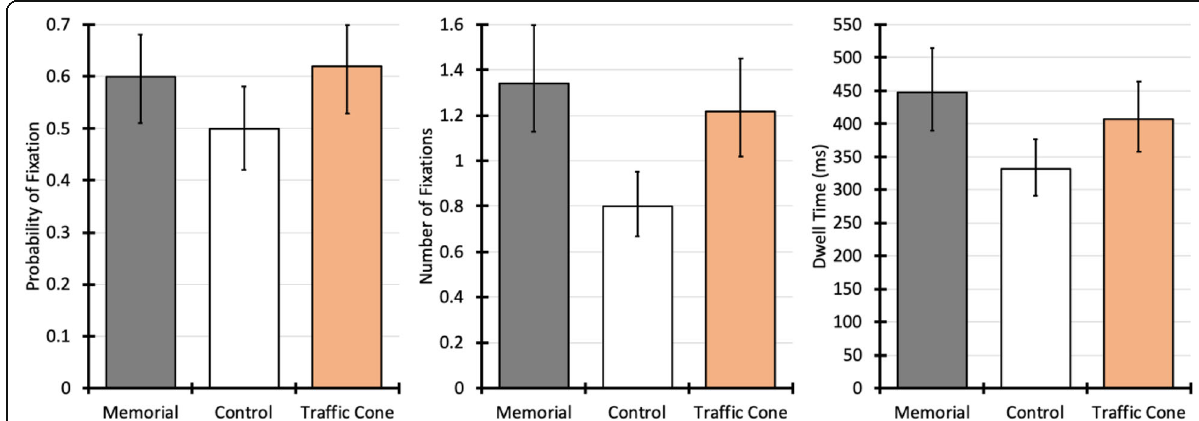
Fig. 1 Eye movements to the left roadside area during the 1314-ms interest period. Error bars represent 95% confidence